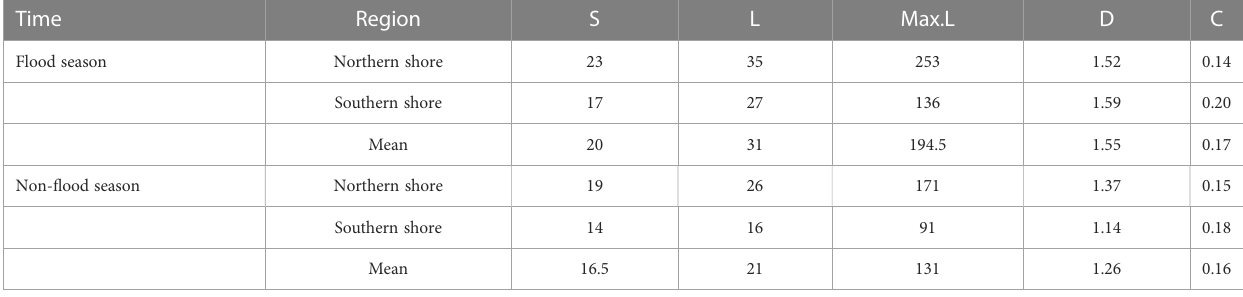
TABLE 3 Metrics of the food web structure of different sampling sites during different hydrological periods.